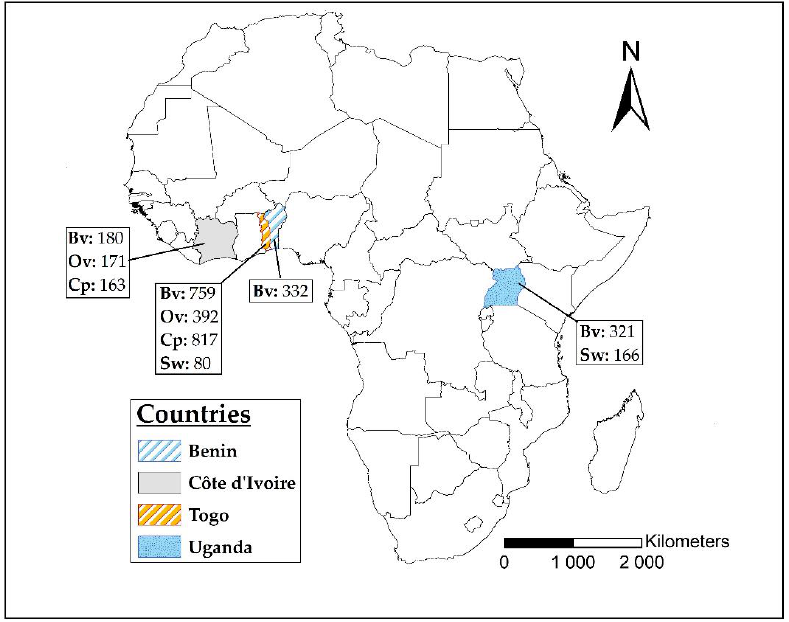
Figure 1. Map of countries where sera were collected. The number of samples collected from each species is indicated. Bv: cattle; Ov: sheep; Cp: goat; Sw: swine. In Uganda, all sera were collected in slaughterhouses. The map was designed using ArcMap 10.4 (ESRI, Redlands, CA, USA).